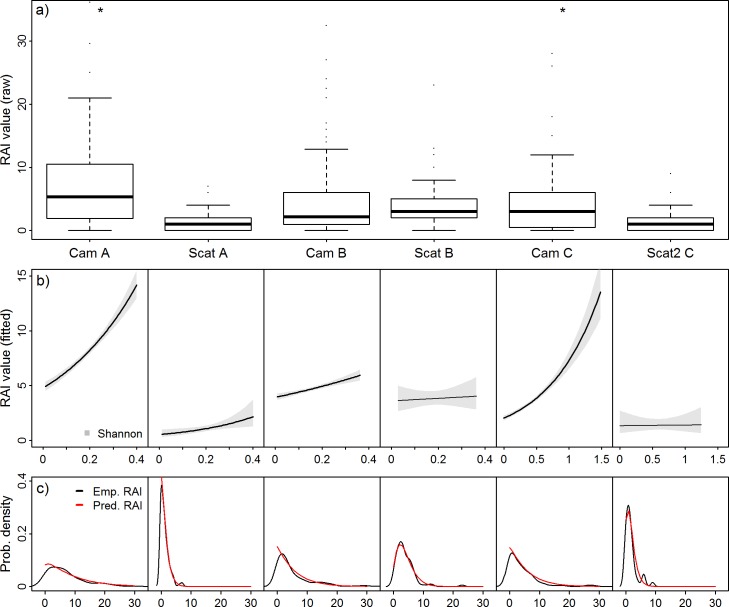
Overview of the results obtained by the methods in each session.Each column corresponds to one method with letters representing the sessions A-C, while rows contain different evaluation metrics for the RAI methods. a) Boxplot of the distribution of raw RAI values (camera data standardized to 21 trapnights); b) Conditional effect plots of the relationship of the predictor Shannon Index of land cover diversity (x-axis)with the RAI as predicted by the final models, with all other predictors set to the mean. A bold line indicates a significant effect in the model. Note the different range of Shannon values in landscapes of session C; c) Empirical and predicted probability density functions for the RAI values (x-axis) obtained from each method. Final models for each method were used for the predicted PDF assuming a negative binomial distribution of the data. *Y-axis scaling in a) omits 4 (Cam A; 3.0%) and 2 (Cam C; 2.6%) RAI values > 36.